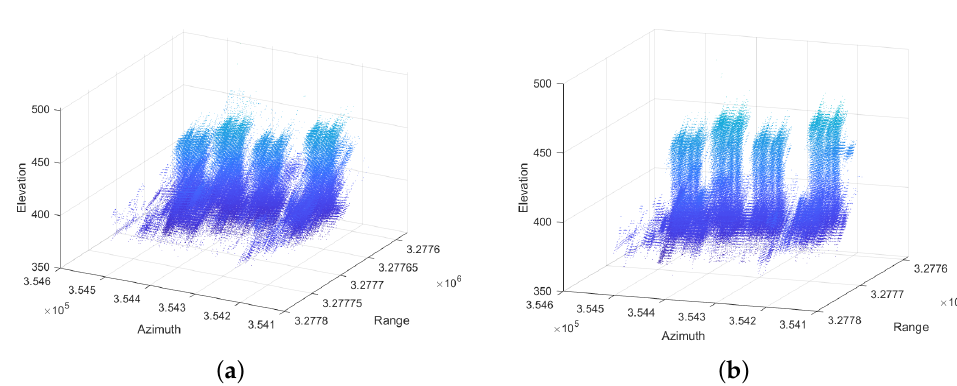
Figure 23. The comparison of 3D reconstruction point cloud results. ( a ) The comparison method; ( b ) the proposed